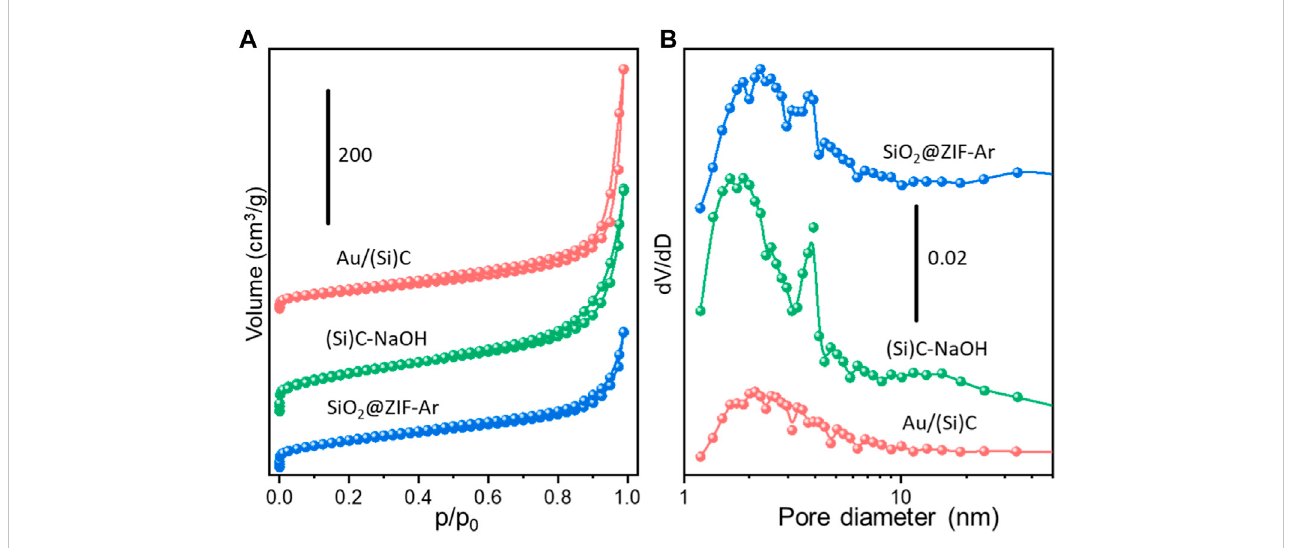
FIGURE 3 (A) N 2 adsorption-desorption isotherms and and Au/(Si)C after gold loading and